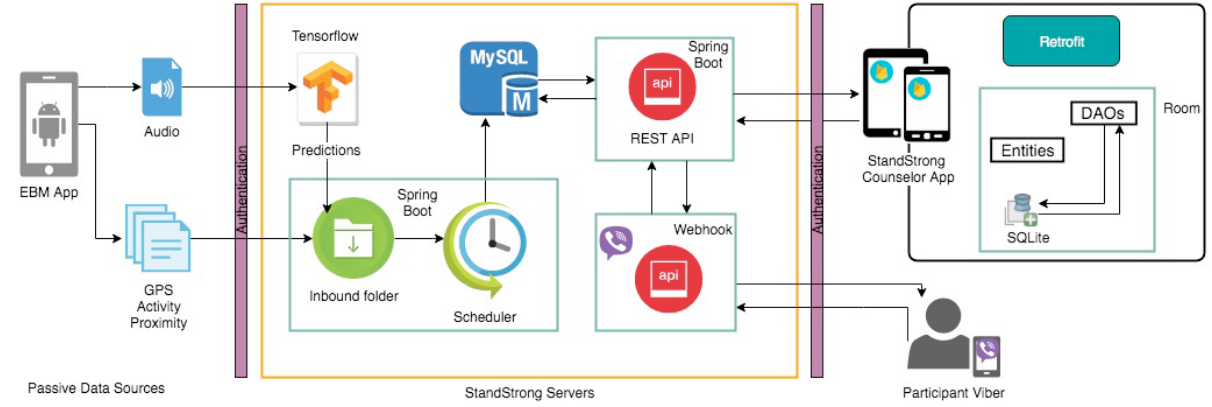
Figure 1. Architecture of StandStrong platform. EBM: Electronic Behavior Monitoring; DAO: Data Access